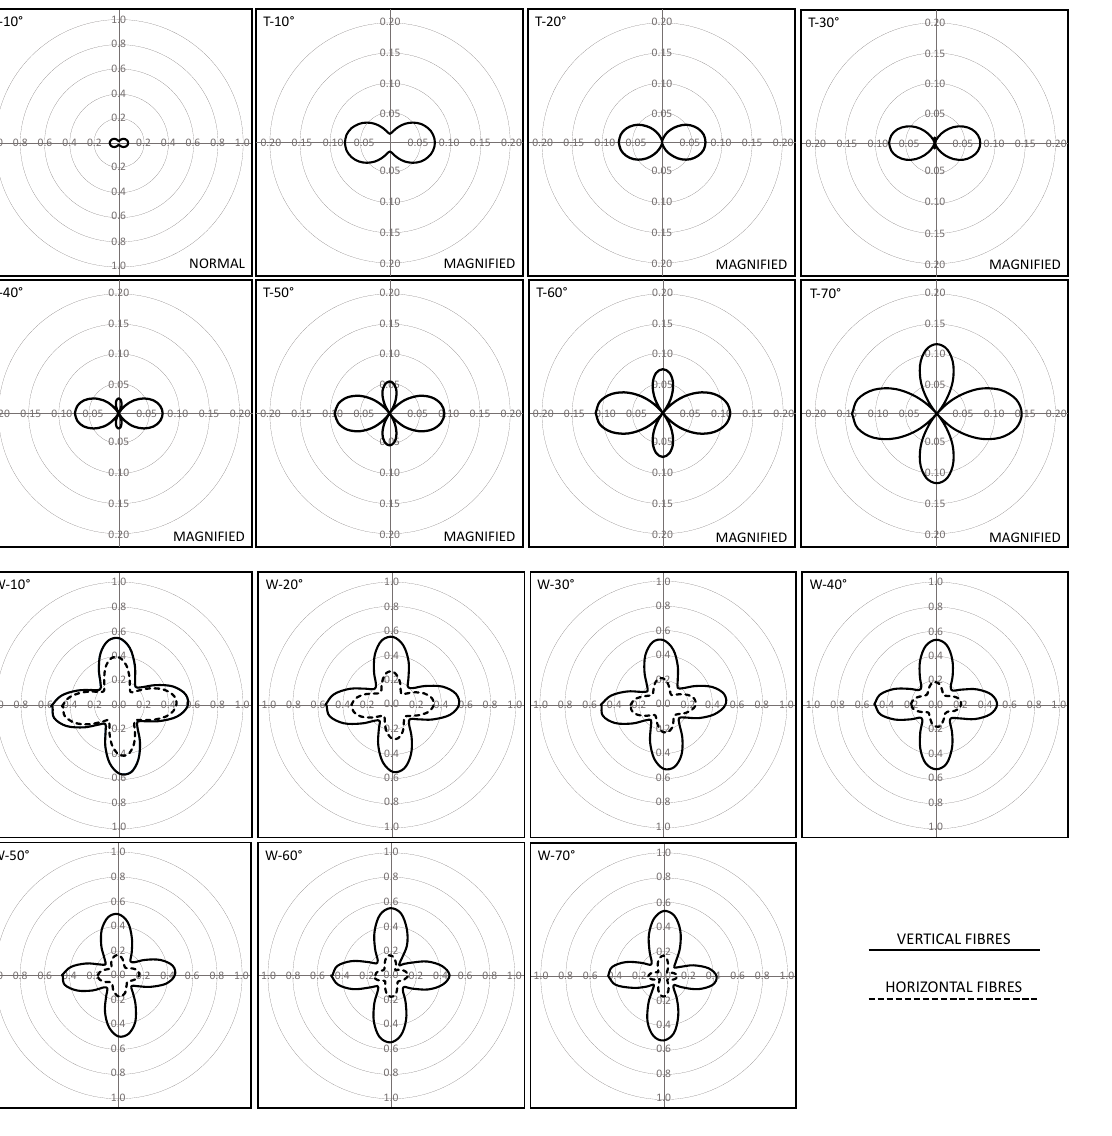
Figure 8. Polar representation of linear dichroism as the azimuth angle of observation varies, both for the Teflon samples (8 upper panels) and for those of wood (8 lower panels). The wood represen- tations report both the experimental results for vertically (solid line) and horizontally (dashed line) oriented fibres.